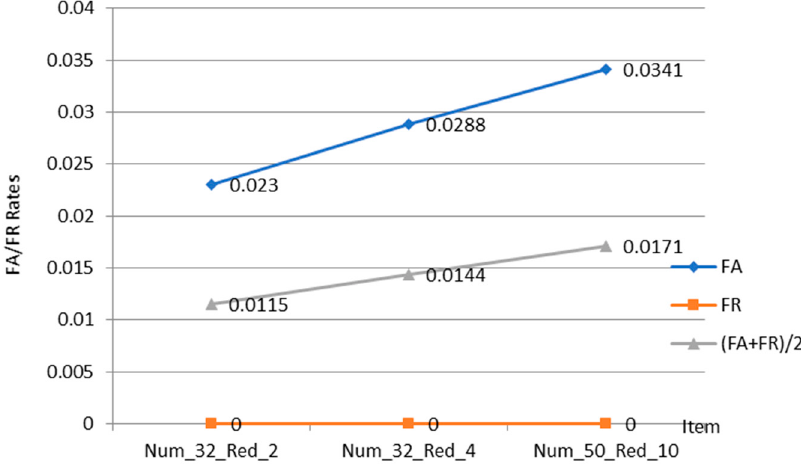
Figure 10. Comparison of DTW and Sparse Combination Parameters in 5D space.